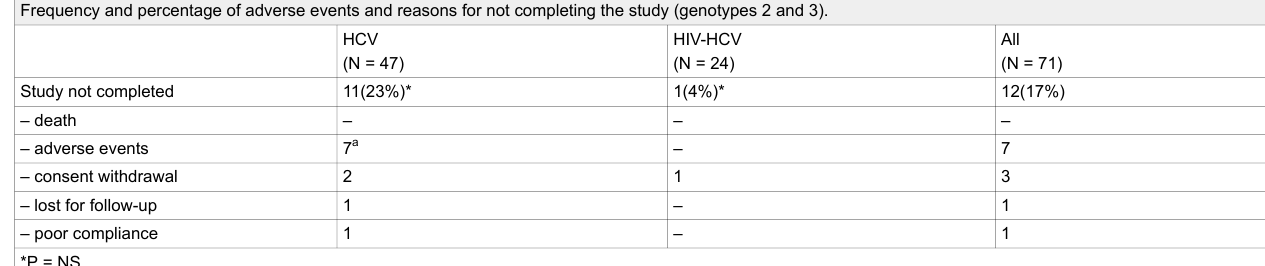
Table 5 Frequency and percentage of adverse events and reasons for not completing the study (genotypes 2 and 3).